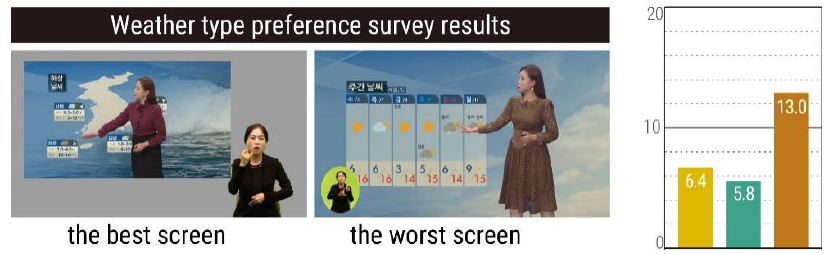
Figure 17. Results of preference evaluation with weather report clips.